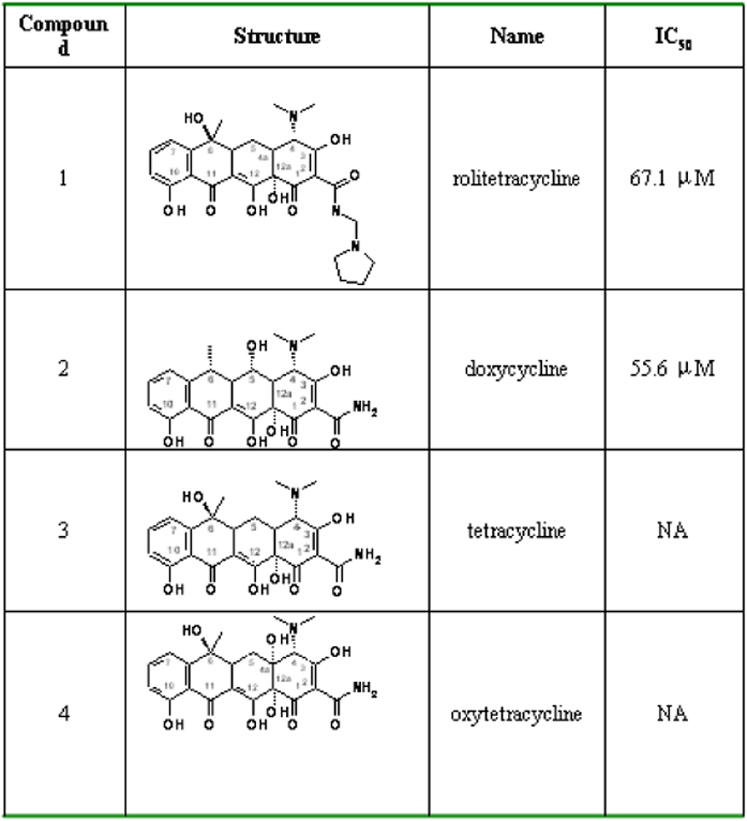
Chemical Structures and IC50s for the tetracycline derivatives.Name, chemical name; IC50, the half maximal inhibitory concentration; NA, not applicable.